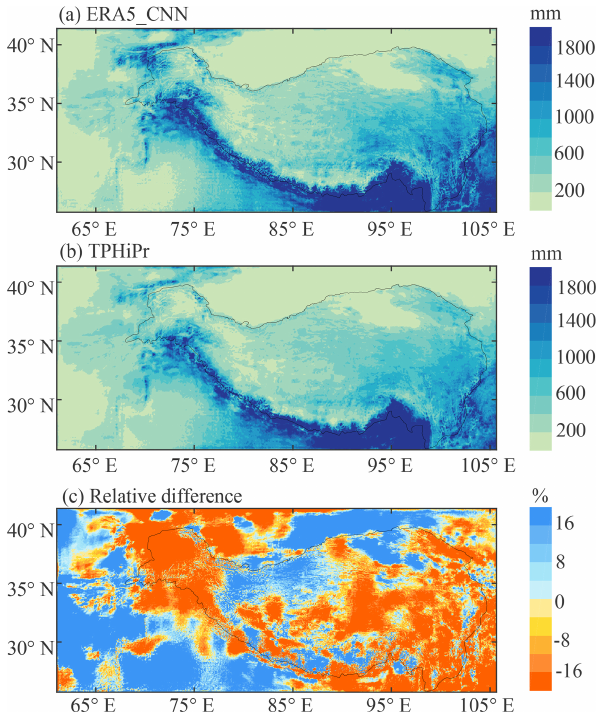
Figure 3. Spatial patterns of the annual average precipitation from (a) ERA5_CNN and (b) the merged data (TPHiPr), as well as (c) the relative difference between them. The precipitation is averaged over the period from 1979 to 2020. The relative difference is cal- culated by subtracting ERA5_CNN from TPHiPr and then dividing by